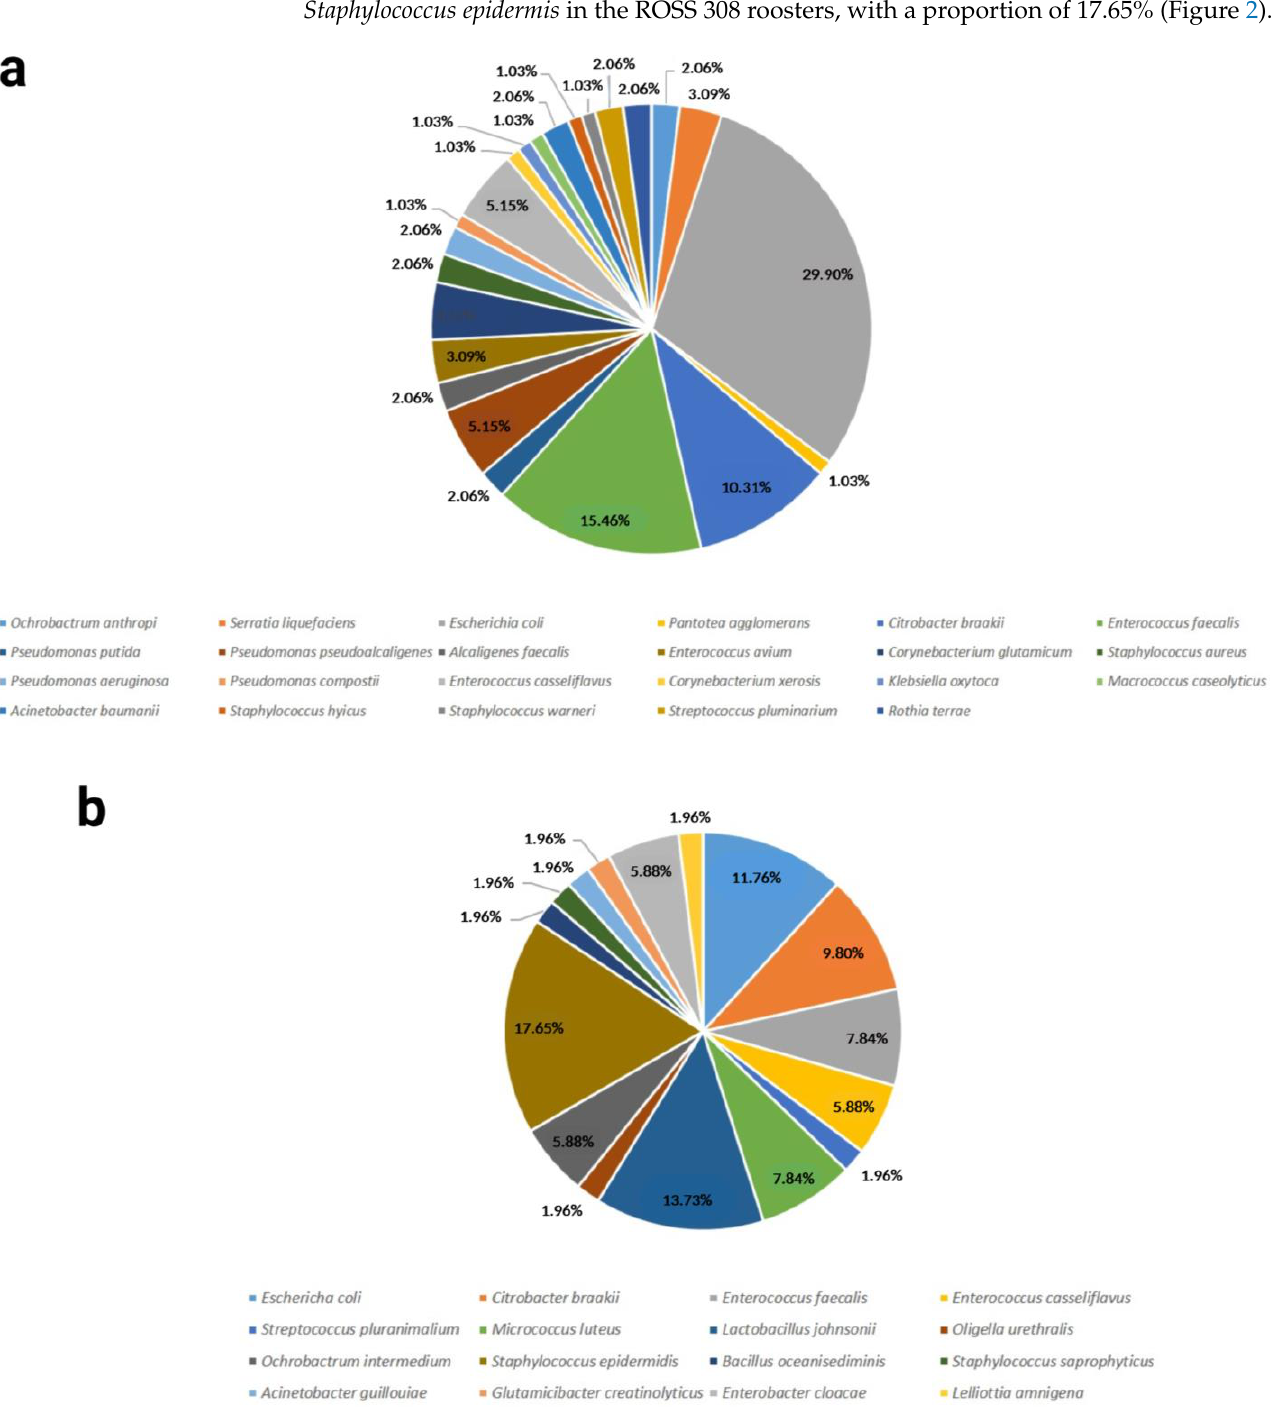
Figure 2. Bacterial species identified in the analyzed breeds and their proportions. ( a ) Lohman Brown breed, ( b ) ROSS 308